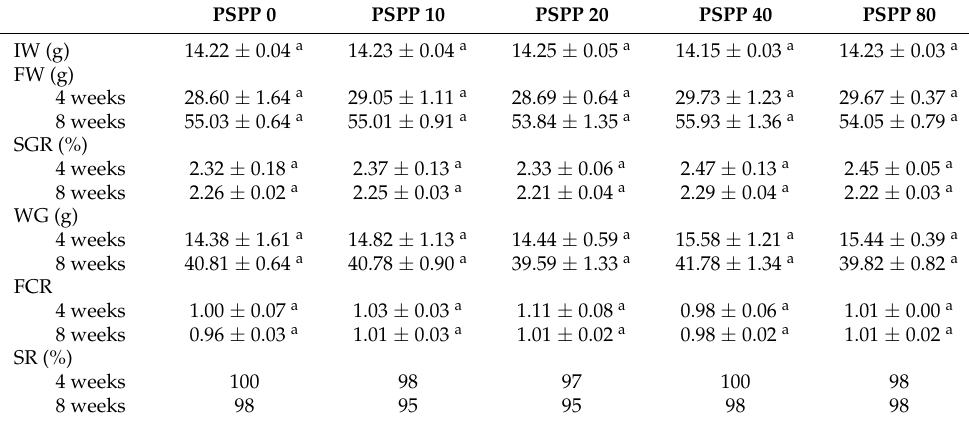
Table 3. Growth performances and feed utilization in Nile tilapia with different levels of PSPP- supplemented diets after four and eight weeks of the feeding trial. Different letters in the same row indicate statistically significant differences ( p < 0.05). Data are presented as mean ±